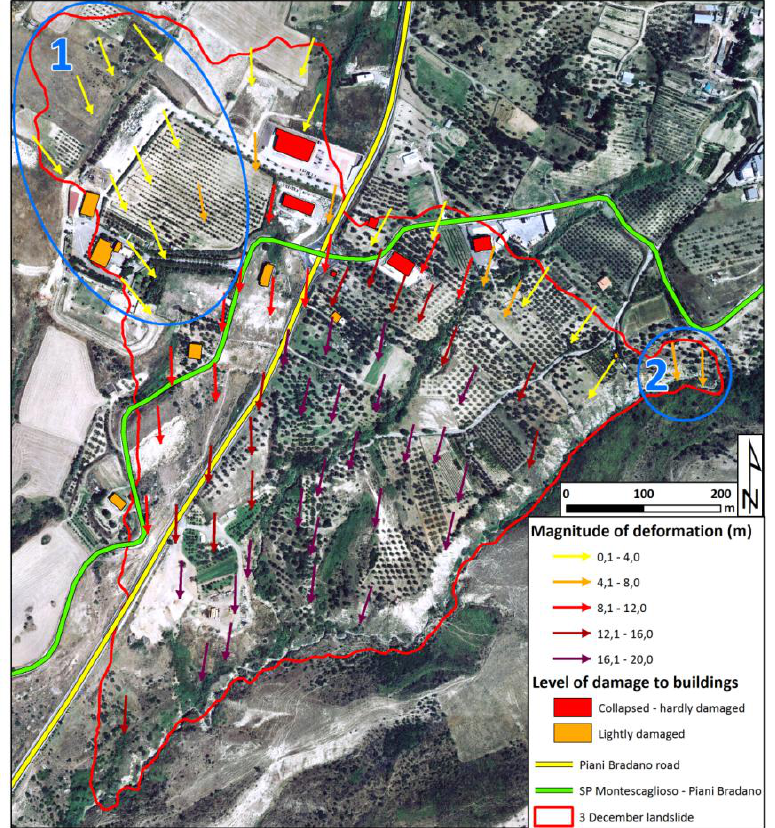
Figure 7. Magnitude and direction of the 3D deformation field of the 3 December 2013 landslide on the south-west slope of Montescaglioso. The map shows also the main road network and the level of damage to buildings. Secondary landslides are circled in